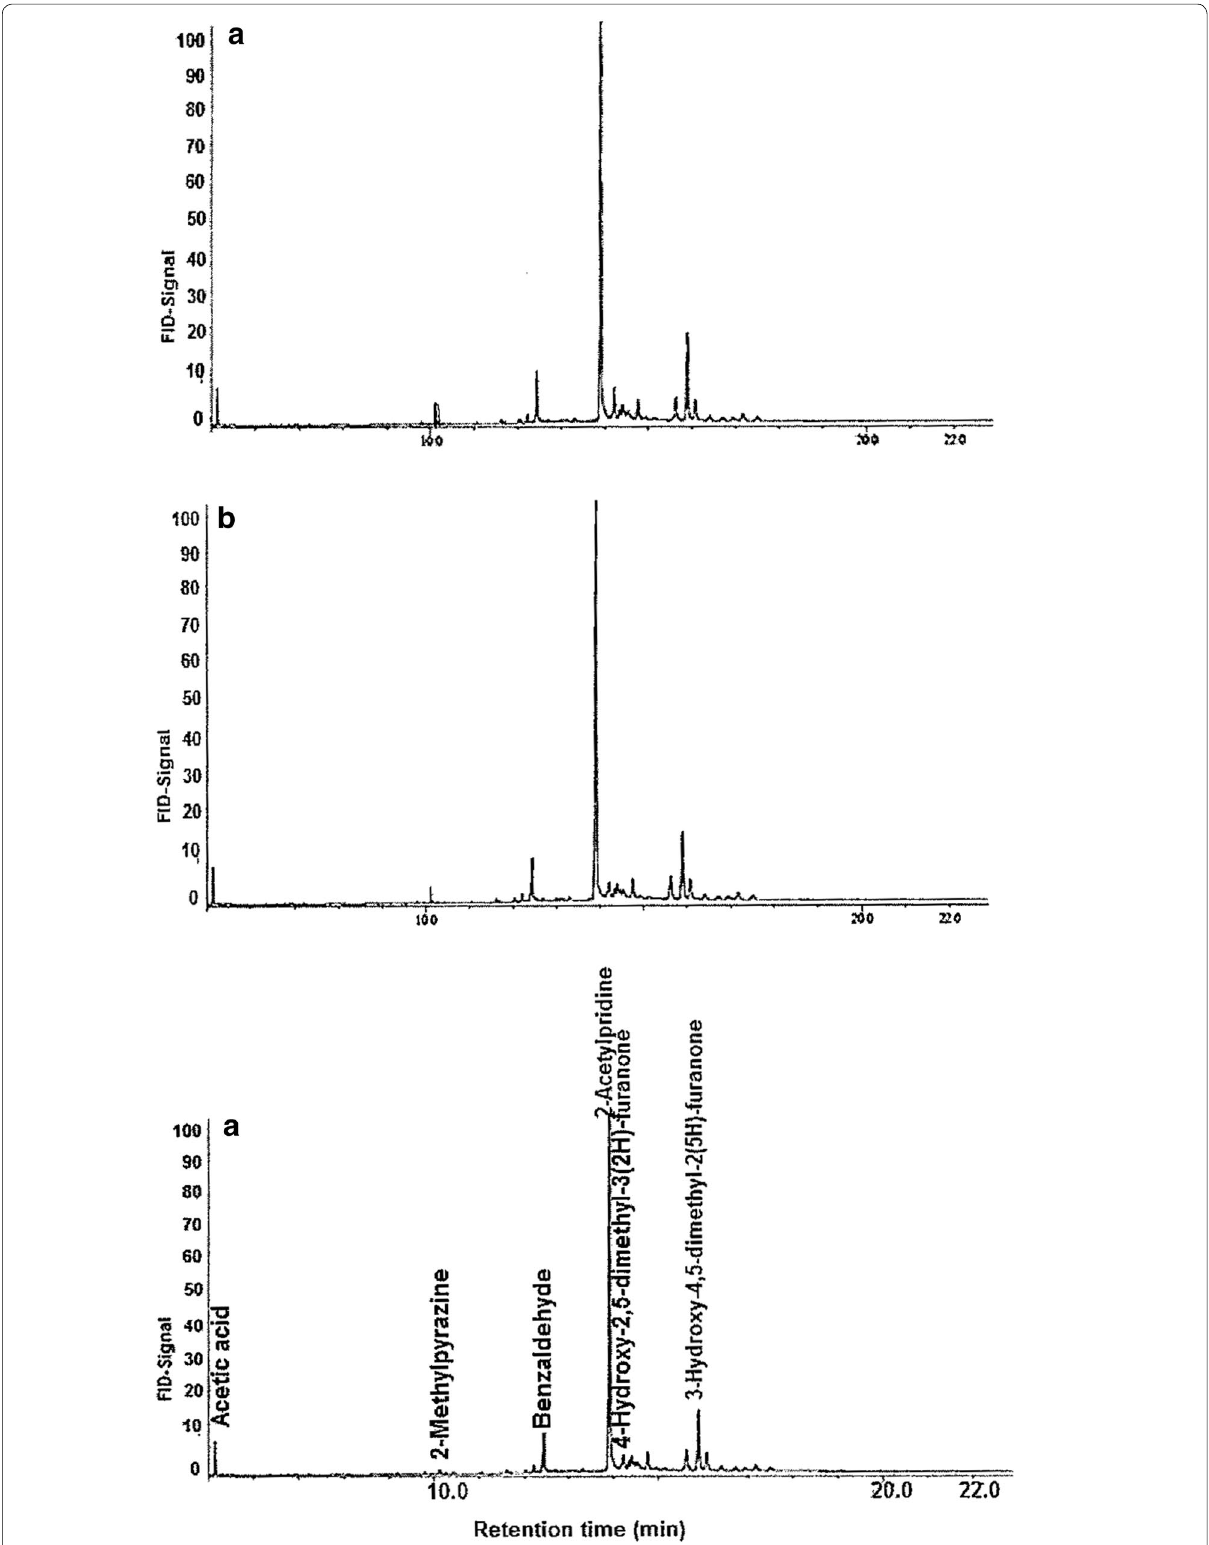
Fig. 1 Characteristic gas chromatograms of solvent extracted African giant snail meat: a raw, b boiled and c